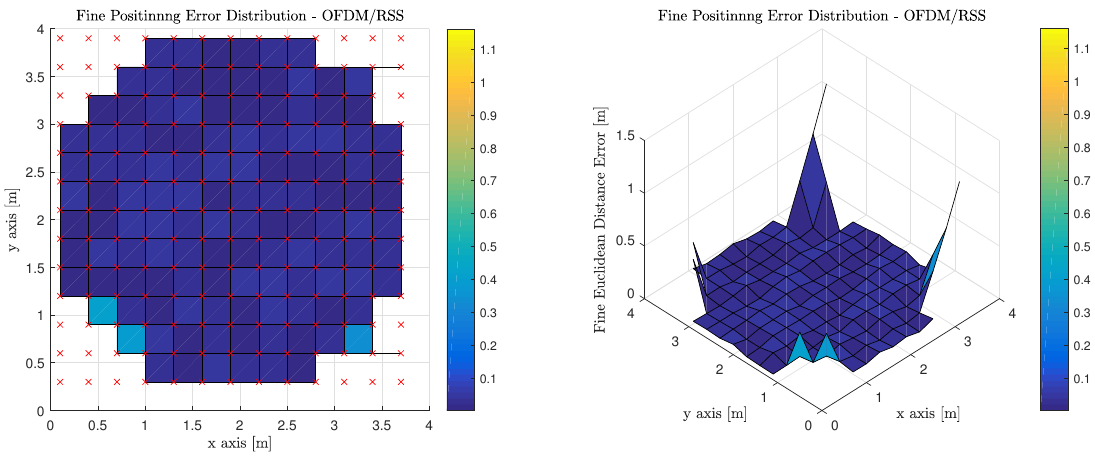
Figure 16. Fine Phase Positioning Performance in Candidate Room using Received Signal Strength Measurement, Least Squares Trilateration Positioning Algorithm and Orthogonal Frequency Division